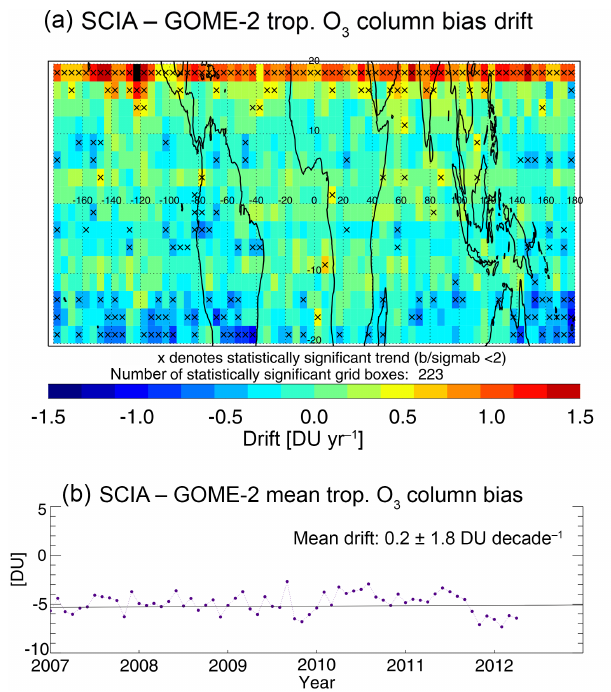
Figure 2. (a) Drift in the correction offset for GOME-2. Black “ × ” denotes statistically significant trend. (b) Average difference and drift in the correction offset for GOME-2 between 2007 and